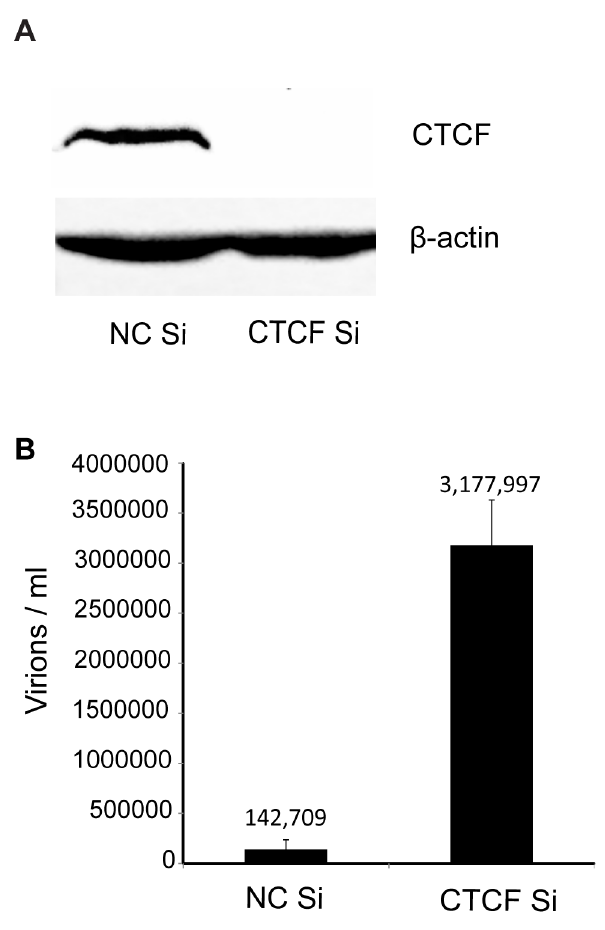
Figure 1. Effect of CTCF depletion on KSHV virion production. A. CTCF knockdown in iSLK cells. Cells were transfected with either negative control siRNA (NC Si) or siRNA specific for CTCF (CTCF Si). Cell lysates were prepared 48 h after transfection and analyzed by immunoblotting with an anti-CTCF antibody (upper panel). Blots were stripped and re-probed with an anti-actin antibody as a loading control (lower panel). B. KSHV virus production in cells depleted of CTCF. KSHV- infected iSLK cells were transfected with either control siRNA (NC Si) or CTCF-specific siRNA (CTCF Si) and KSHV replication was induced by treatment with doxycycline. Supernatants from induced cells were used to infect 293 cells. Virus passage was quantitated by flow cytometry of GFP-positive 293 cells. Each transfection/induction was performed in triplicate and three replicate infections were performed with each supernatant. Uninduced cell supernatants from control and CTCF depleted cells contained less than twenty-five detectable infectious particles per ml (data not